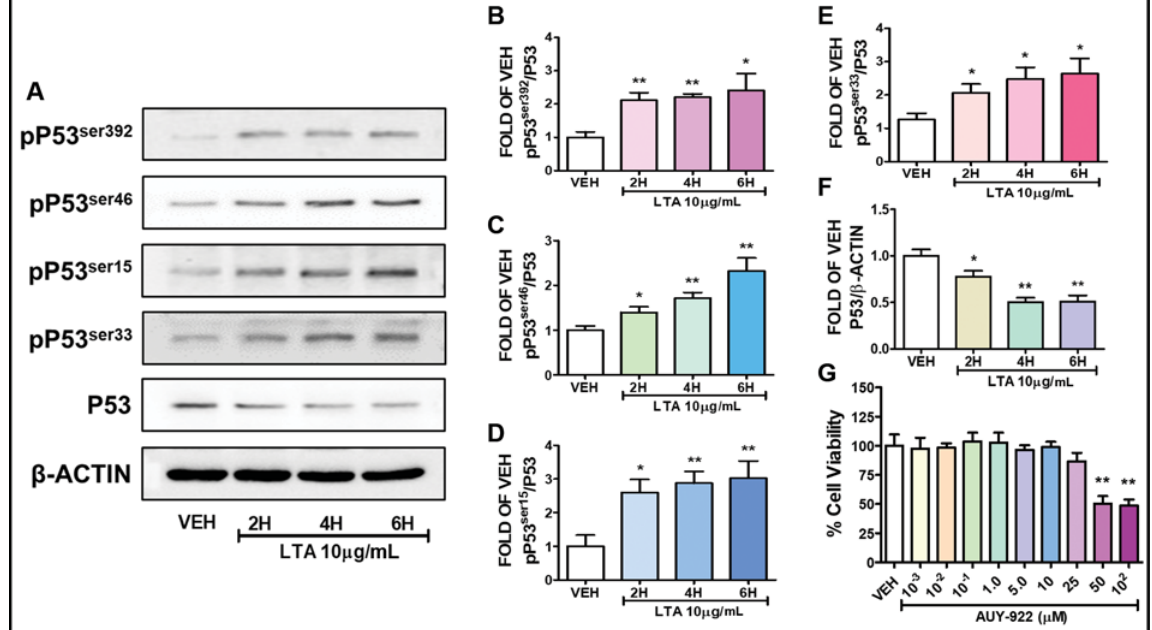
Fig. 1 ( A – F ) Western blot analysis of phosphorylated P53 (pP53 ser392 , pP53 ser46 , pP53 ser15 , pP53 ser33 ) and total P53 expression after treatment of bovine pulmonary artery endothelial cell (BPAEC) with either lipoteichoic acid (LTA) (10 µg/mL) or vehicle (VEH) (phosphate-buffered saline [PBS]) for 2, 4, and 6hours. The blots shown are representative of three independent experiments. The signal intensity of the protein bands was analyzed by densitometry. Protein levels of phosphorylated P53 and P53 were normalized to P53 and β -actin, respectively. (cid:1) p < 0.05, (cid:1)(cid:1) p < 0.01 vs. VEH. Means (cid:3) standard error of mean(SEM).( G ) Effects of the Hsp90inhibitorAUY-922intheviabilityofHuLEC-5a.CellsweretreatedwitheitherVEH(0.1%dimethylsulfoxide[DMSO])or AUY-922 (10 (cid:4) 3 , 10 (cid:4) 2 , 10 (cid:4) 1 , 1.0, 5.0, 10.0, 25.0, 50.0, 100 µM) for 24hours. Cell viability was evaluated by employing the 3-(4,5-dimethylthiazol-2-yl)-2,5- diphenyltetrazolium bromide (MTT) assay. (cid:1)(cid:1) p < 0.01 vs. VEH, n ¼ 3. Means (cid:3)